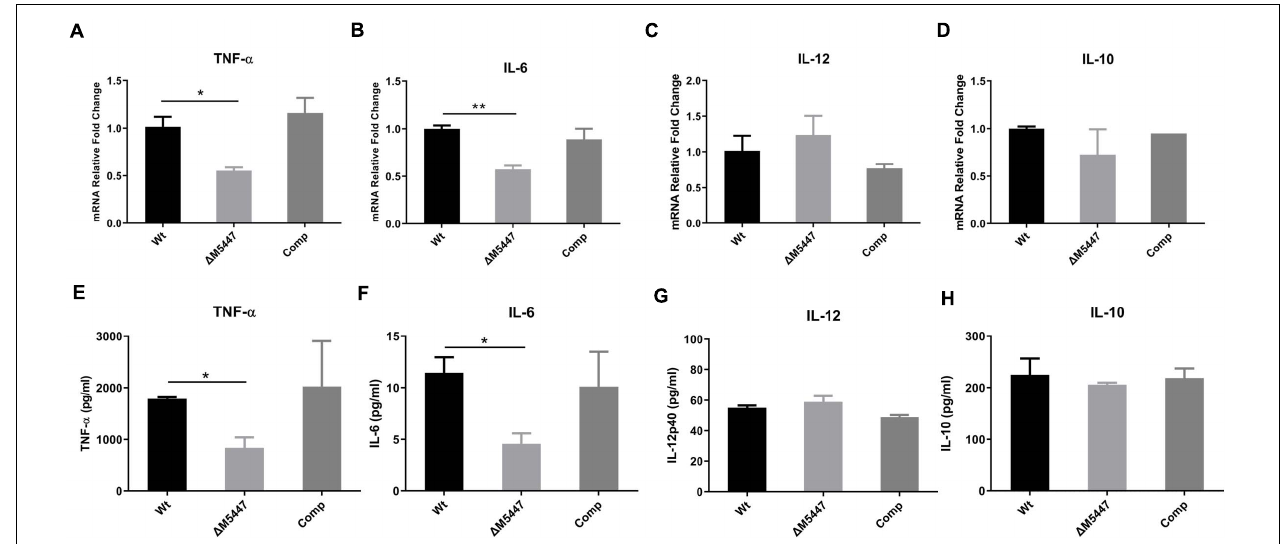
FIGURE 5 | (cid:49) M5447 strain decreased the production of pro-inflammatory cytokines in macrophage. THP-1 macrophages were infected with Wt, (cid:49) M5447, and Comp strains for 3 h at a MOI of 10. Total RNA of infected cells was extracted at 24 h post-infection, and the transcription levels of TNF- α (A) , IL-6 (B) , IL-12p40 (C) , and IL-10 (D) were measured by qPCR. Their mRNA levels were normalized by GAPDH mRNA. Culture supernatants were collected, and the production of TNF- α (E) , IL-6 (F) IL-12p40 (G) , and IL-10 (H) was evaluated by ELISA. Data were shown as mean ± SD of triplicate wells. Statistical analyses were performed by the method of two-tailed t -test (* p < 0.05, ** p <